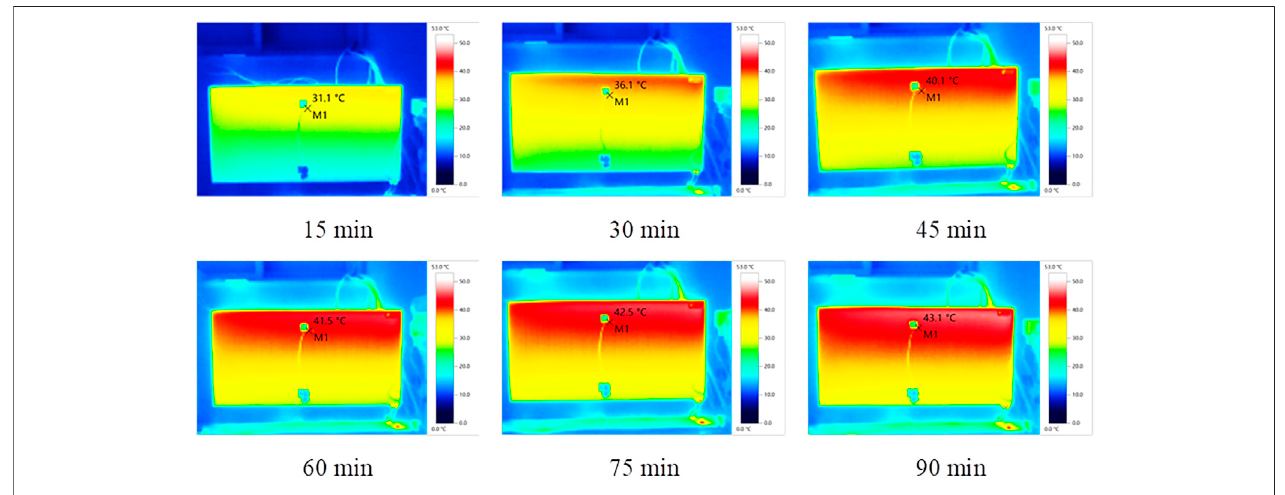
FIGURE 4 | Radiator temperature during the system start-up.